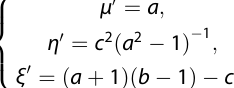
ffiffiffiffiffiffiffiffiffiffiffiffiffiffiffiffiffiffiffiffiffiffiffiffiffiffiffiffiffi p ð a þ 1 Þð b (cid:1) 1 Þ